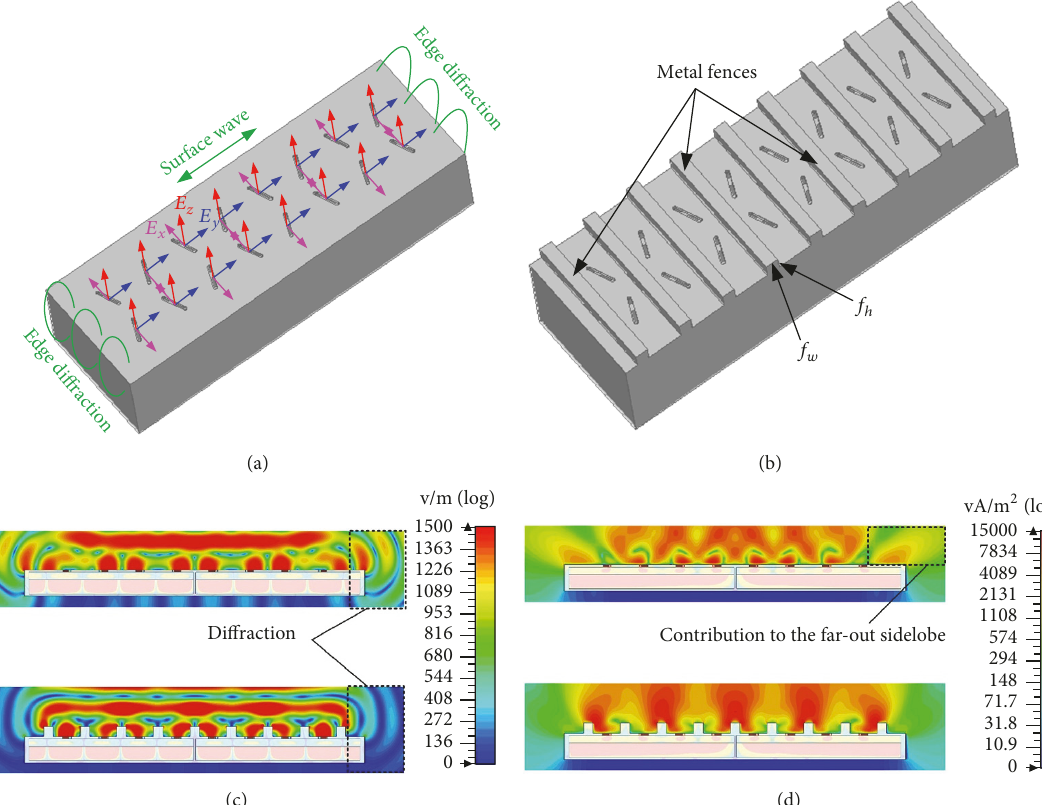
Figure 6: (a) Radiation analysis of antenna array. (b) Antenna array with metal fences. (c) 𝐸 -field distribution. (d) Power flow distribution in the 𝑦 - 𝑧 plane at 35 GHz.